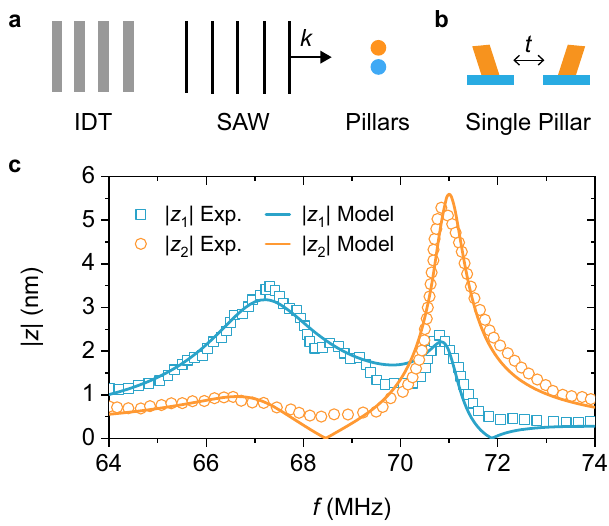
Fig. 5 A pair of pillar resonators driven by a surface acoustic wave (SAW). a Schematic top view on the sample illustrating the orientation of the pillar pair regarding the incident SAW. The SAW is created by an interdigital transducer (IDT) and the pillars vibrate in the fi rst bending mode. The distance between the pillars is d = 5.9 μ m. b Schematic side view of a single pillar illustrating the pillars' motion ( fi rst bending mode). c Experimental frequency response of the pillar pair measured by laser scanning heterodyne interferometry. The experimental data are taken from Raguin et al. 30 . The solid lines result from a fi t of Eq. (15) to the experimental